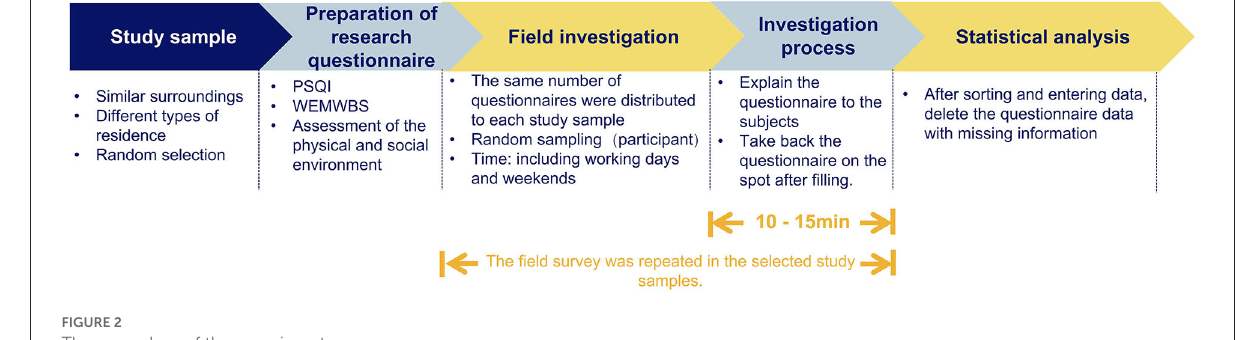
FIGURE2 The procedure of the experiment.